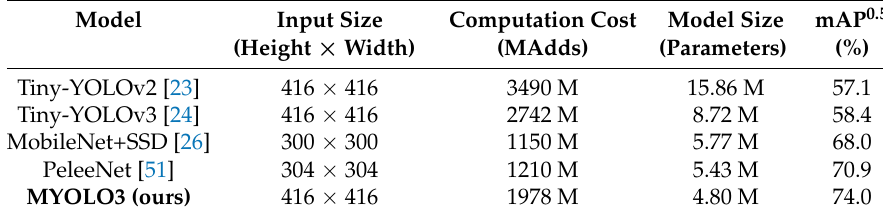
Table 2. Performance comparison of real-time object detectors on PASCAL VOC 2007. M denotes million, mAP 0.5 denotes that the accuracy predicted on the original PASCAL VOC 2007 test dataset when the value of IoU is 0.5.